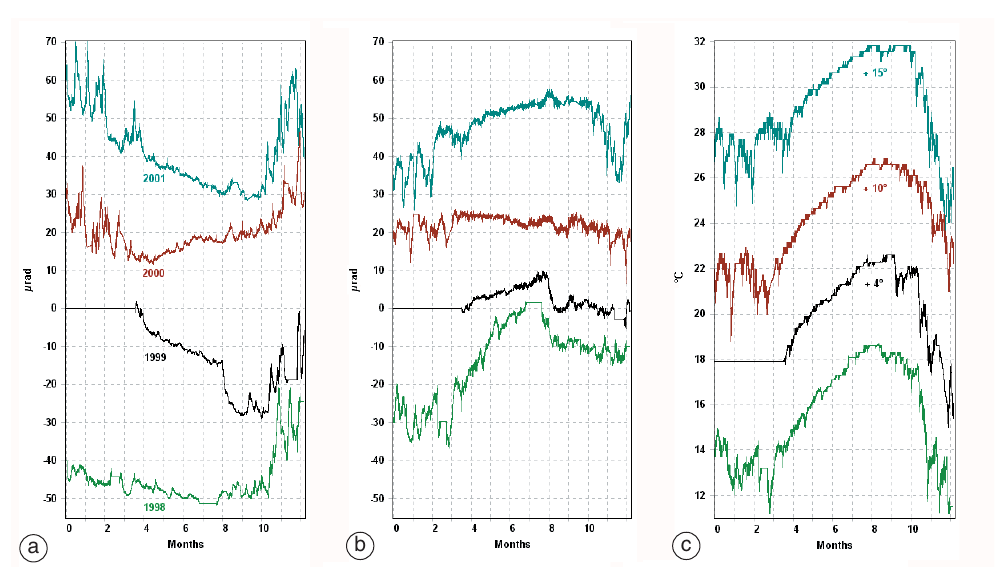
Fig. 12a-c. This figure shows a comparison between Tilt NS (a), EW (b) and Te (c) recorded at DMB station over the years 1998, 1999, 2000 and 2001. Note the opposite trend in the NS (a) and EW (b) components recorded in 2000.